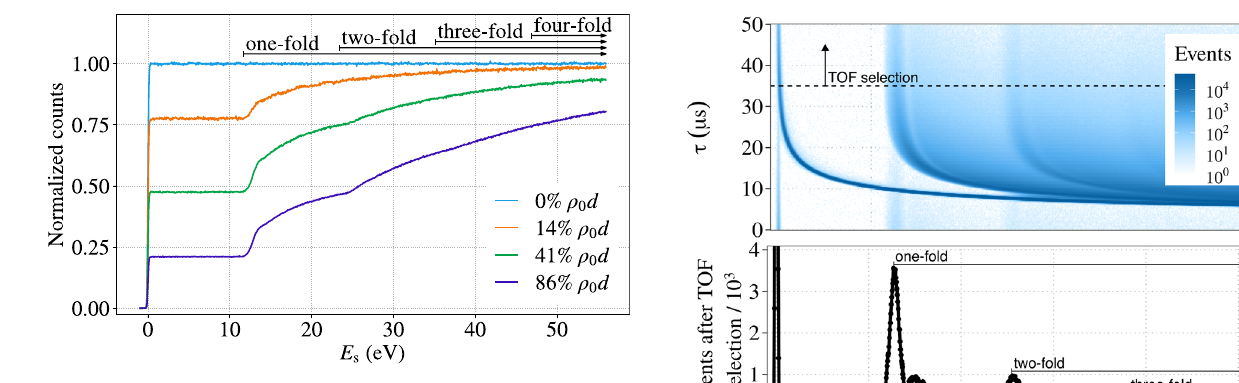
Fig. 3 The measured response functions in integral mode at different fractions of the nominal column density ρ 0 d . The response functions are normalized by the electron rate of the reference measurement with an empty source (blue curve). The arrows indicate the energy region where n -fold scattering takes place